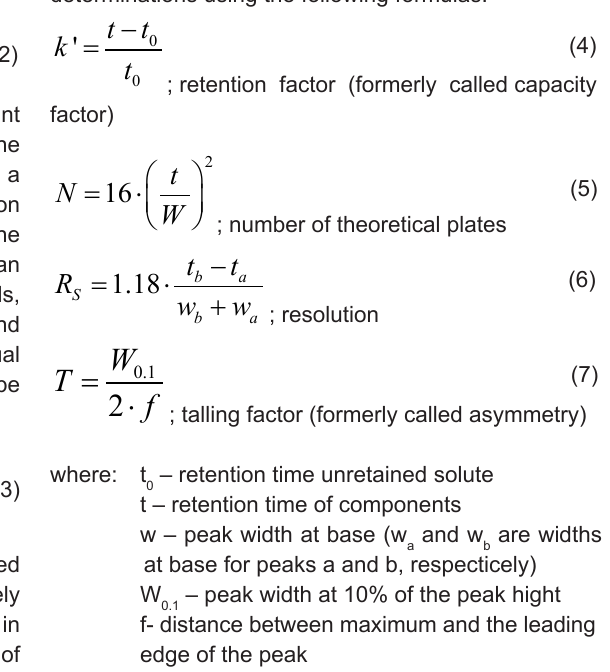
mobile phase and column temperature. According to